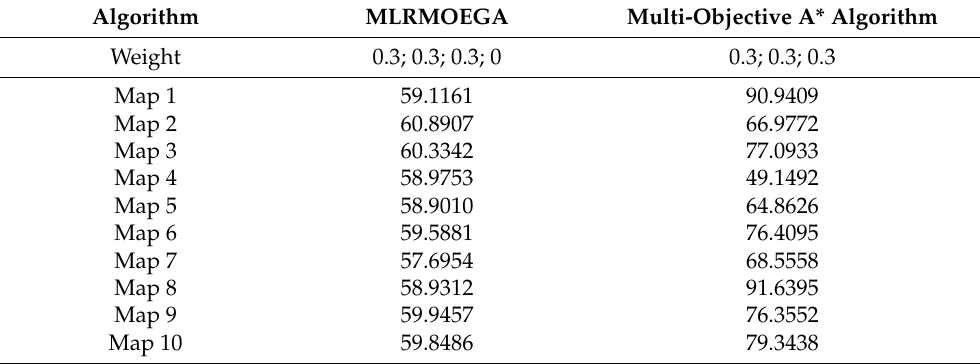
Table 10. The values of synthetic objective function compared with multi-objective A*